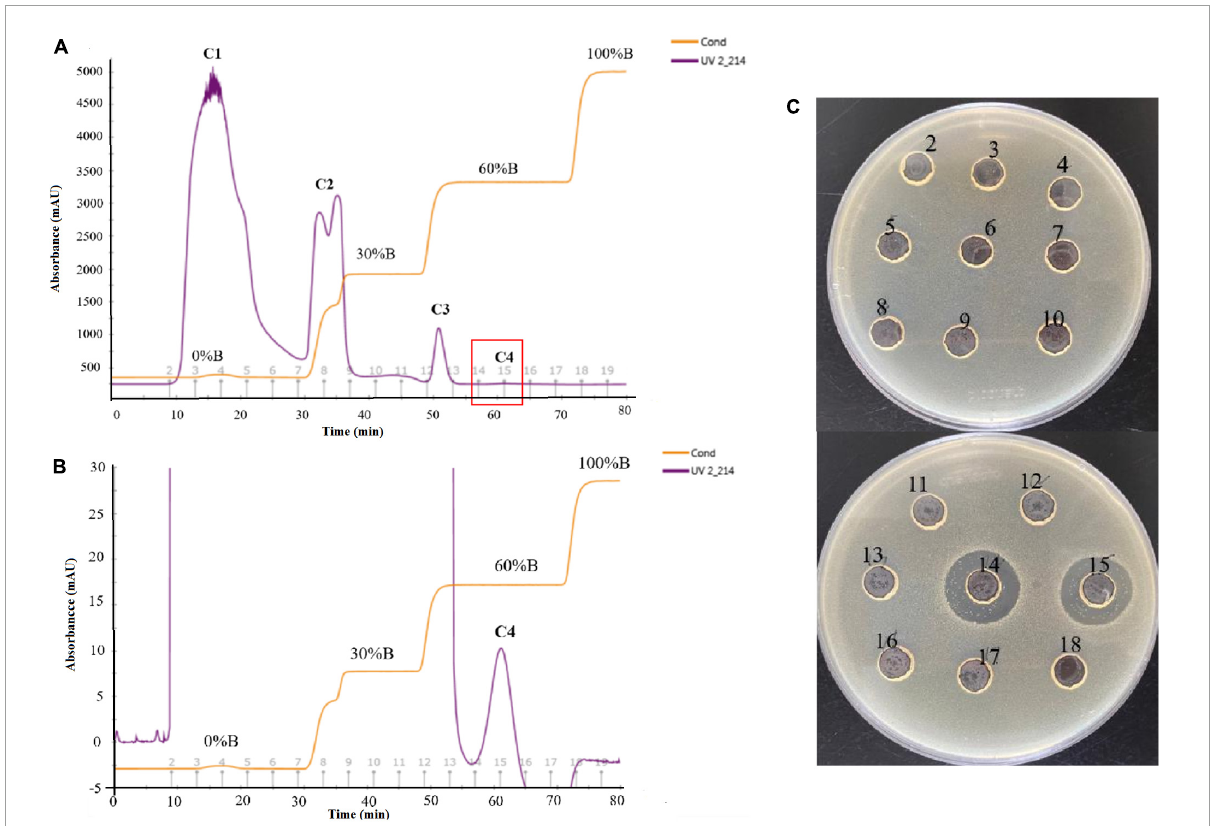
FIGURE3 Purification of the antimicrobial agent from the crude extract by CM Sepharose Fast Flow column (A) , zoom in locally on the peak C4 (B) , and determination of the antimicrobial activity of different tubes against E. coli ATCC 25922 (C) . The elution components were collected with 8 ml per tube (the serial number of each tube was marked on the abscissa from 2 to 19), three distinct peaks C1 (tubes 2–6), C2 (tubes 7–9), C3 (tube12), and one not obvious peaks C4 (tubes 14 and 15) were isolated, zooming out the range of the longitudinal axis could exhibit the C4 clearly (B)